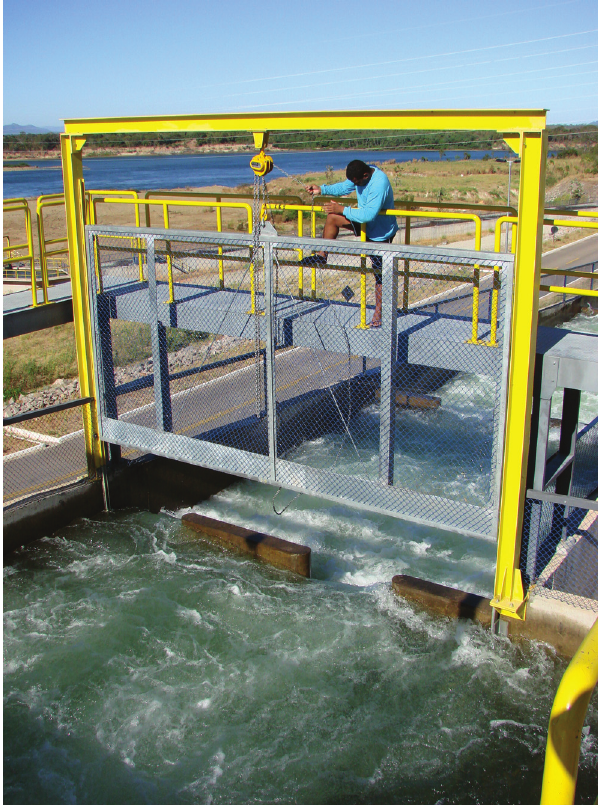
Fig. 1. Screen used to block fish passage through the ladder at Peixe Angical Dam. In this picture, the screen is shown in lifted position (before the beginning of the